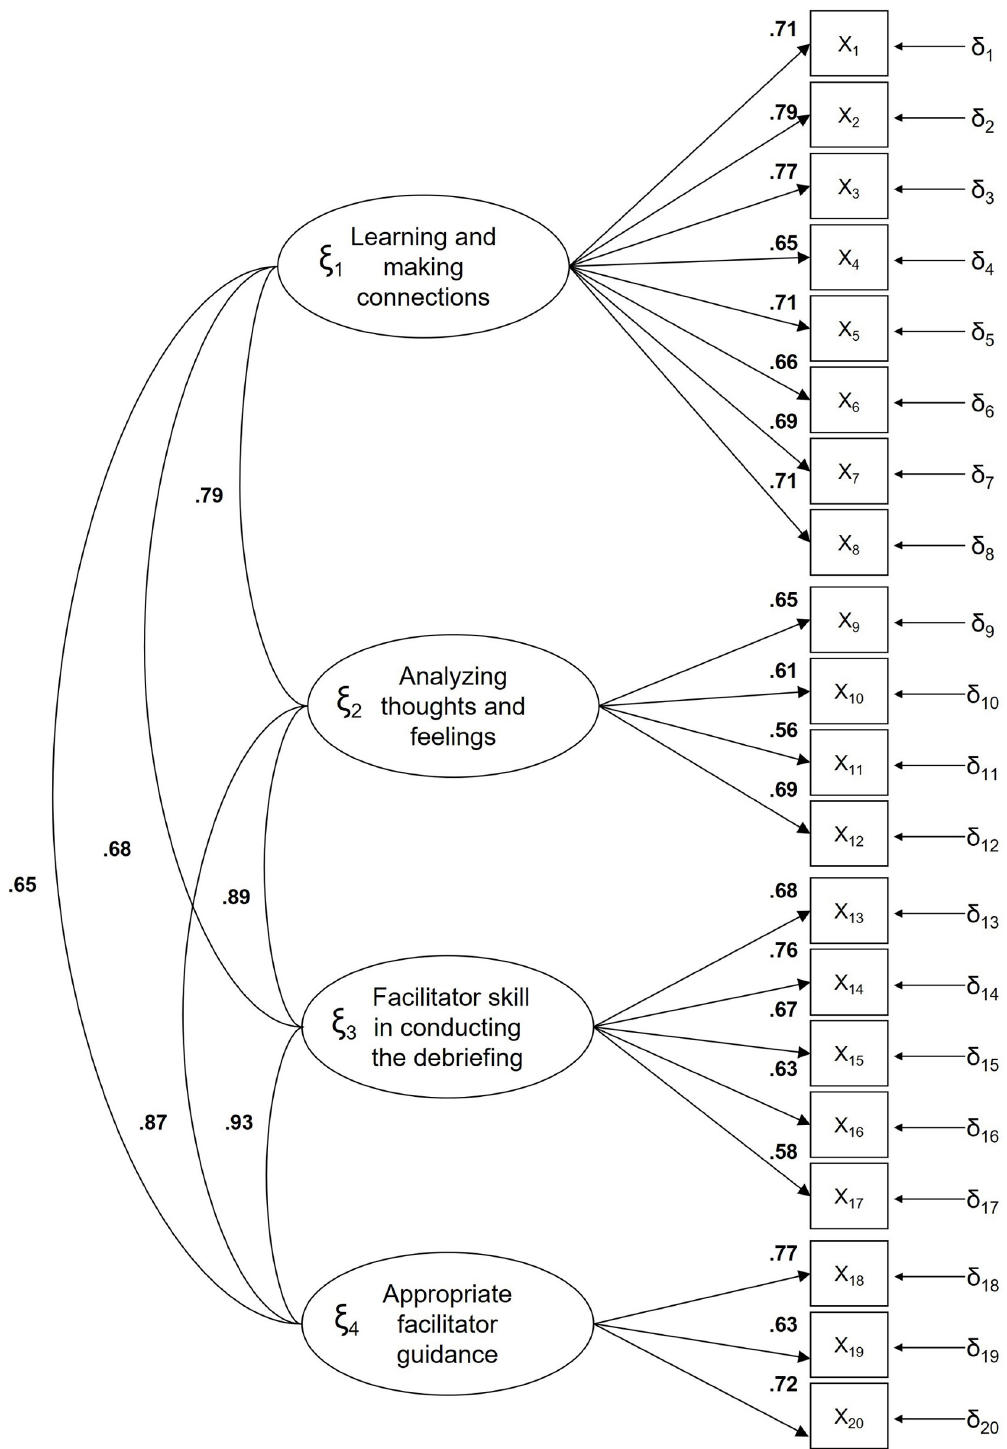
Fig 1. Standardized model parameters for the Debriefing Experience Scale for experience of simulation.